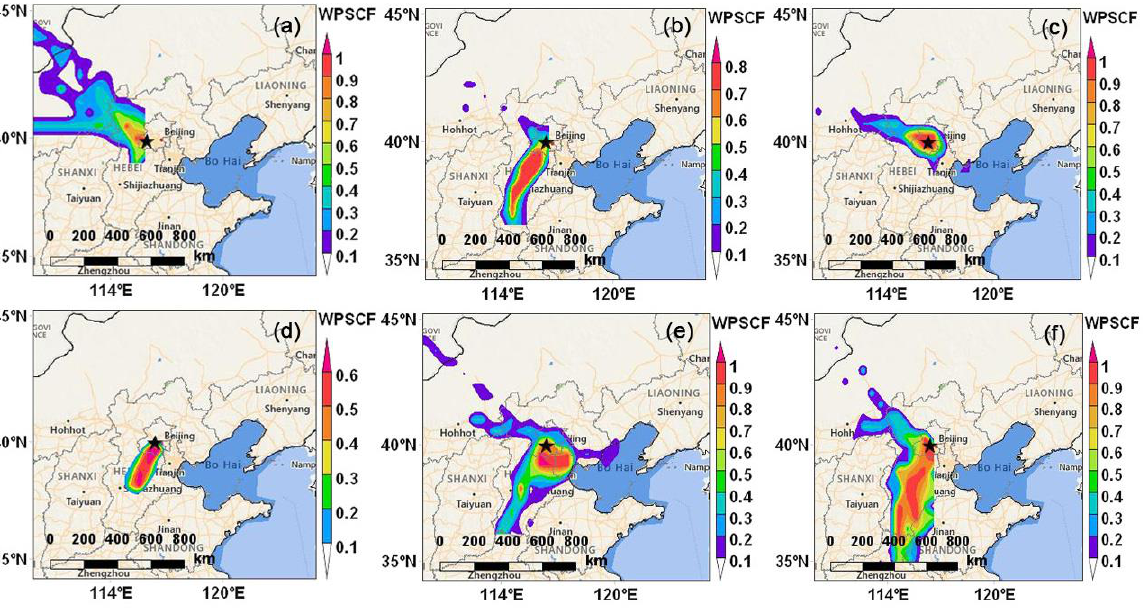
Figure 6. Maps of weighted potential source contribution function (WPSCF) for PM 2.5 arriving in Beijing during the six heavy PM 2.5 pollution episodes (HPEs). ( a ) HPE1, ( b )HPE2, ( c ) HPE3, ( d ) HPE4, ( e ) HPE5, and ( f ) HPE6.